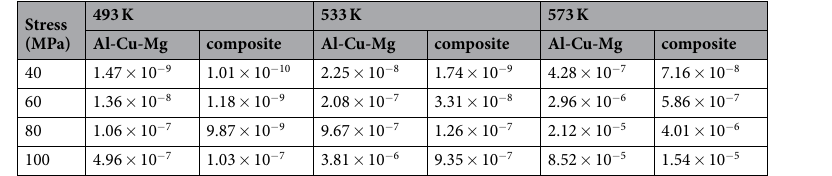
Table 1. The steady-state creep rate data of Al-Cu-Mg alloy and 9 vol.% nano-sized TiC x /Al-Cu-Mg composite under different applied stresses of 40, 60, 80 and 100 MPa at various